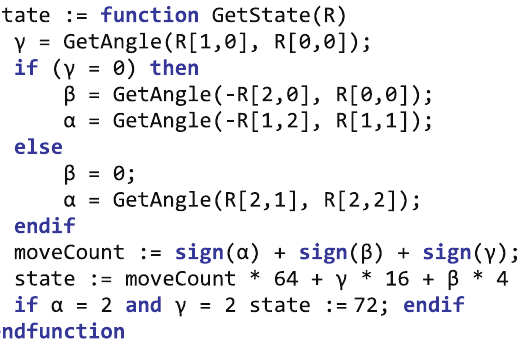
Figure 3: De fi nition of the cubie ’ s orientation state